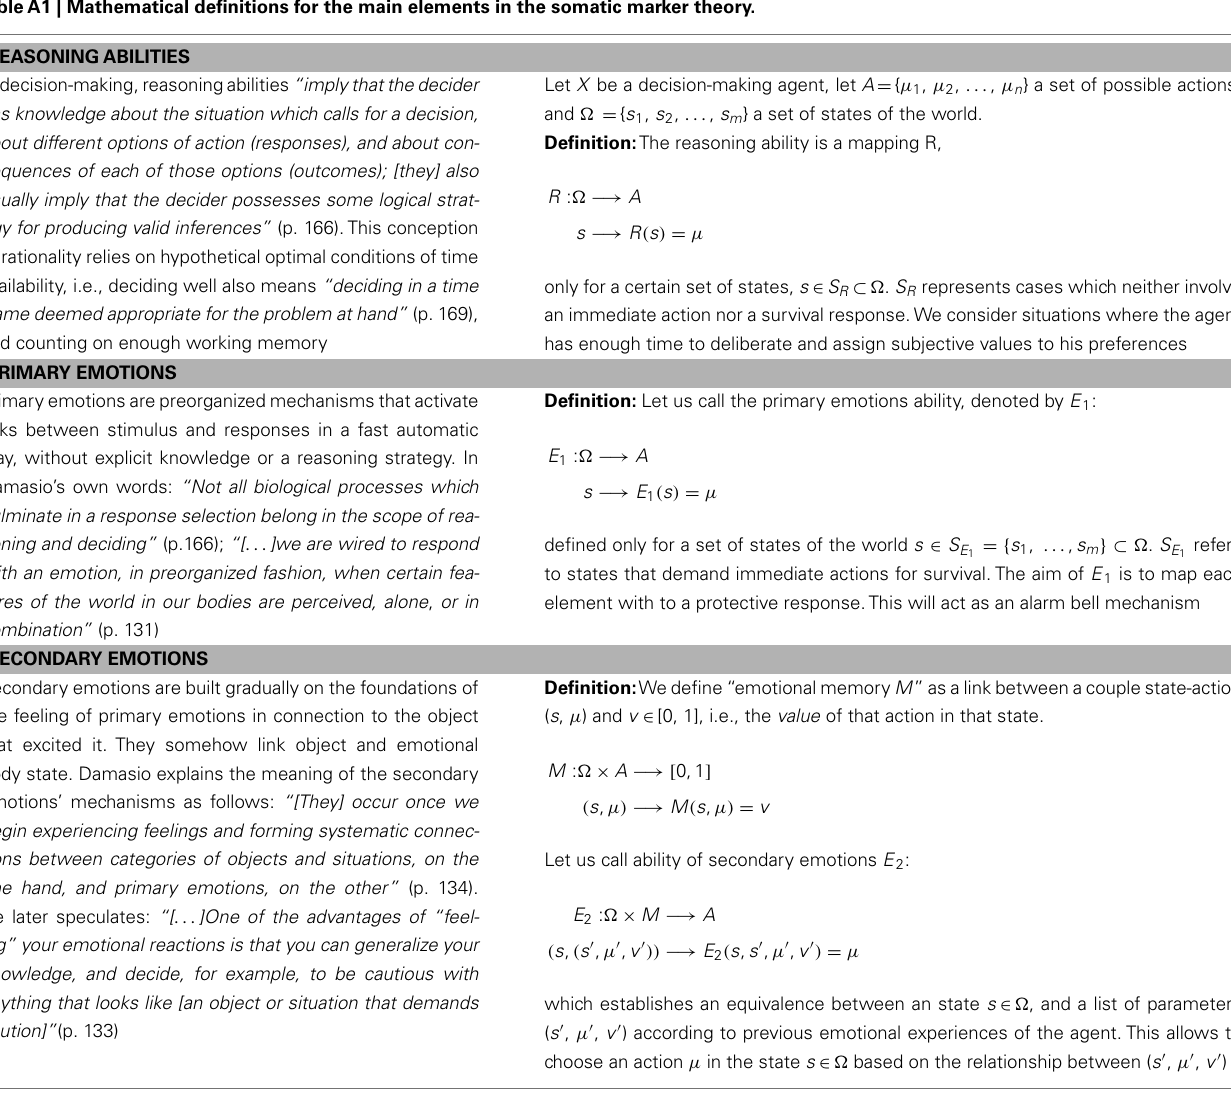
TableA1 | Mathematical definitions for the main elements in the somatic marker